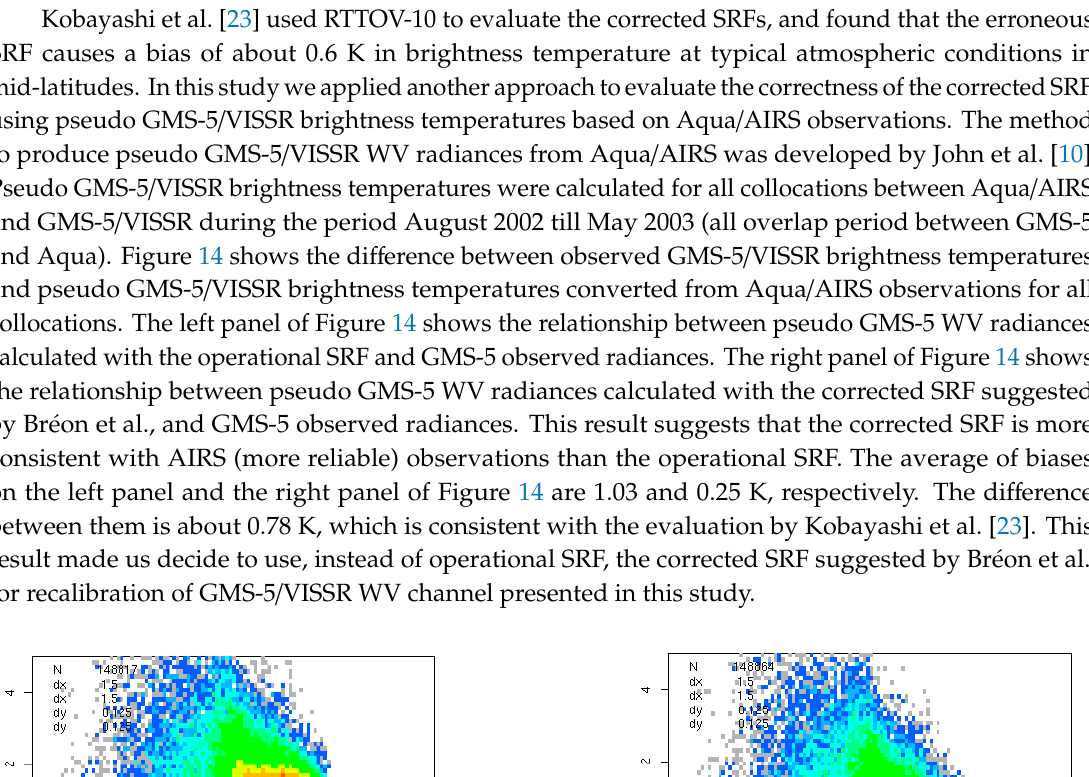
21 of 32 Figure 13. Operational and corrected SRF of GMS-5/VISSR WV channel. Corrected radiance was